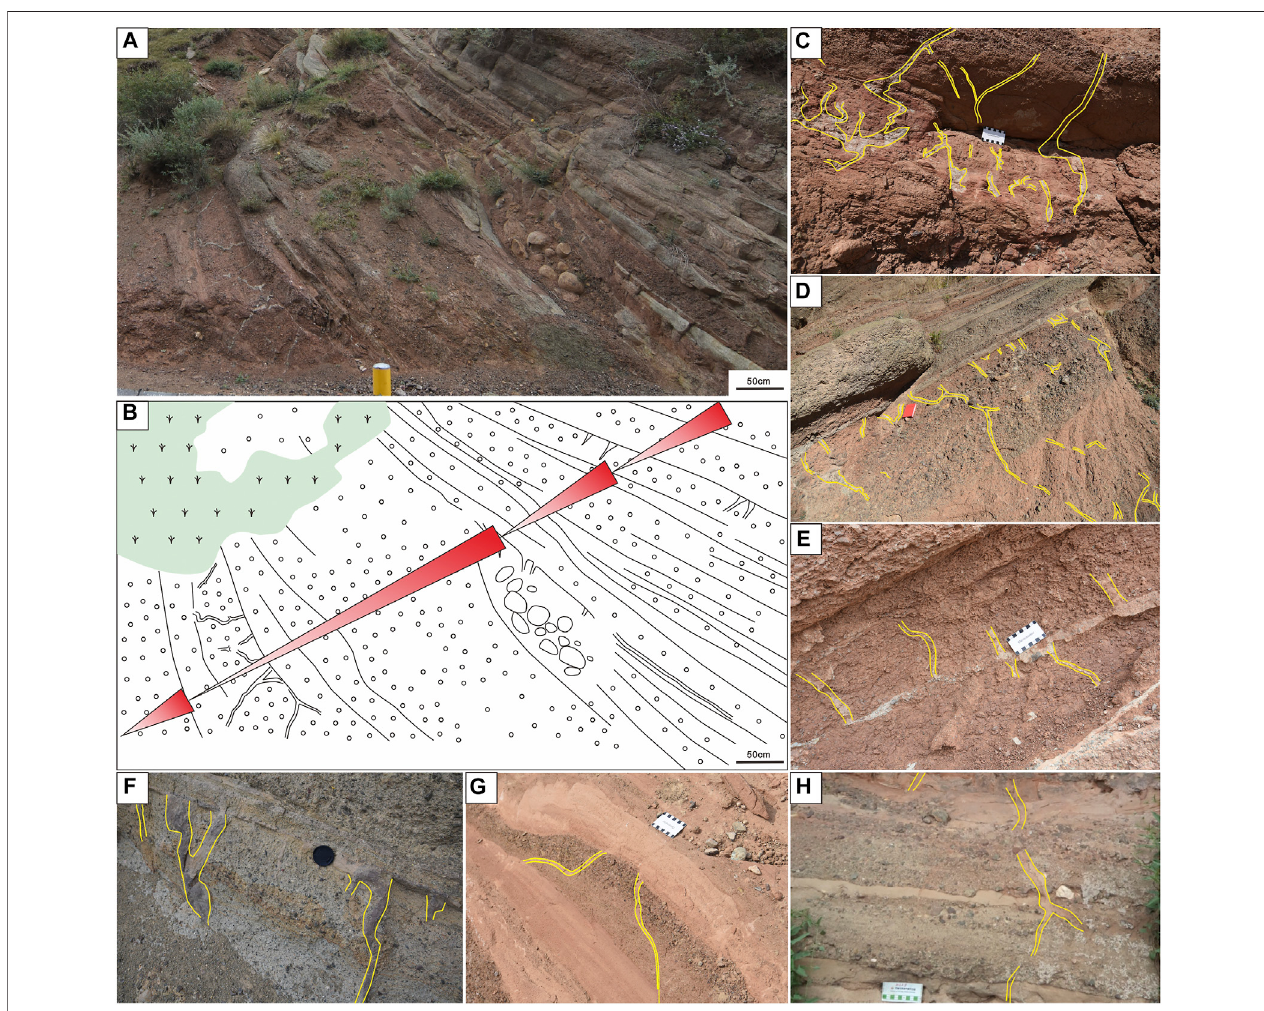
FIGURE 4 | Sedimentary characteristics of the seismites in the late Mesozoic Southern Junggar Basin (A, B) Quergou section, Kalazha Formation; (C) Manasi section, QiguFormation(Guanetal.,2020).Therulerforscale; (D) Quergousection(Guanetal.,2020),KalazhaFormation.Thenotebook(17.5 cm)forscale; (E) Taxihe River section (Guan et al., 2020). The ruler for scale; (F) Jiangong mine section (Guan et al., 2020), Kalazha Formation. The lens cap (7.2 cm) for scale; (G) Baiyanghe section, Kalazha Formation. The ruler for scale; (H) Jiangong mine section (Guan et al., 2020), Kalazha Formation. The ruler for scale.